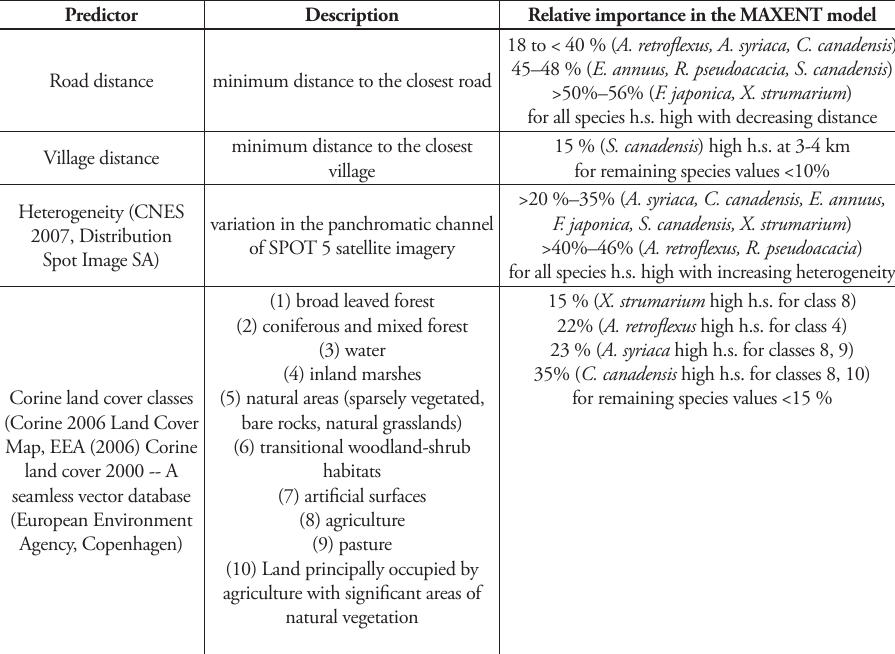
Table 2. Predictors for the MAXENT model. All predictors have a 30 x 30 m resolution. (h.s. = habitat